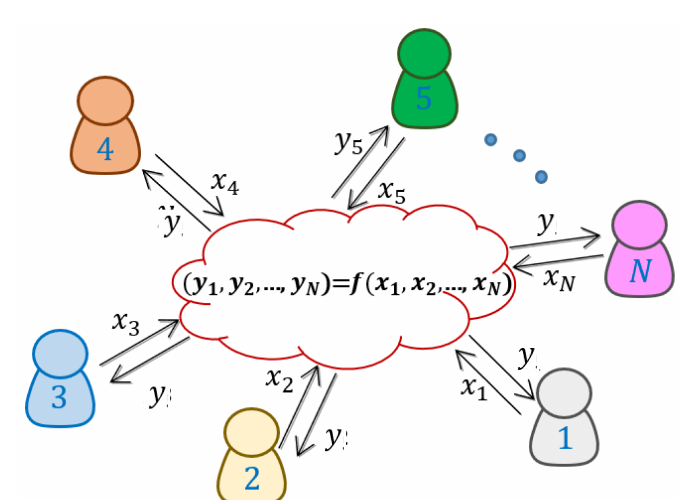
Figure 5 – Graphical presentation of the secure multiparty protocol Рис. 5 − Графическое представление протокола